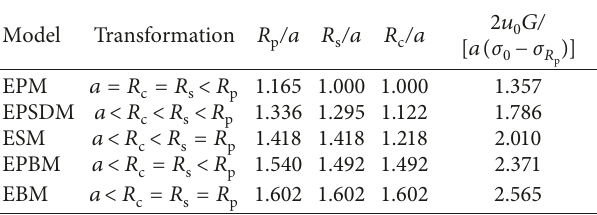
, R , and R p s c under different